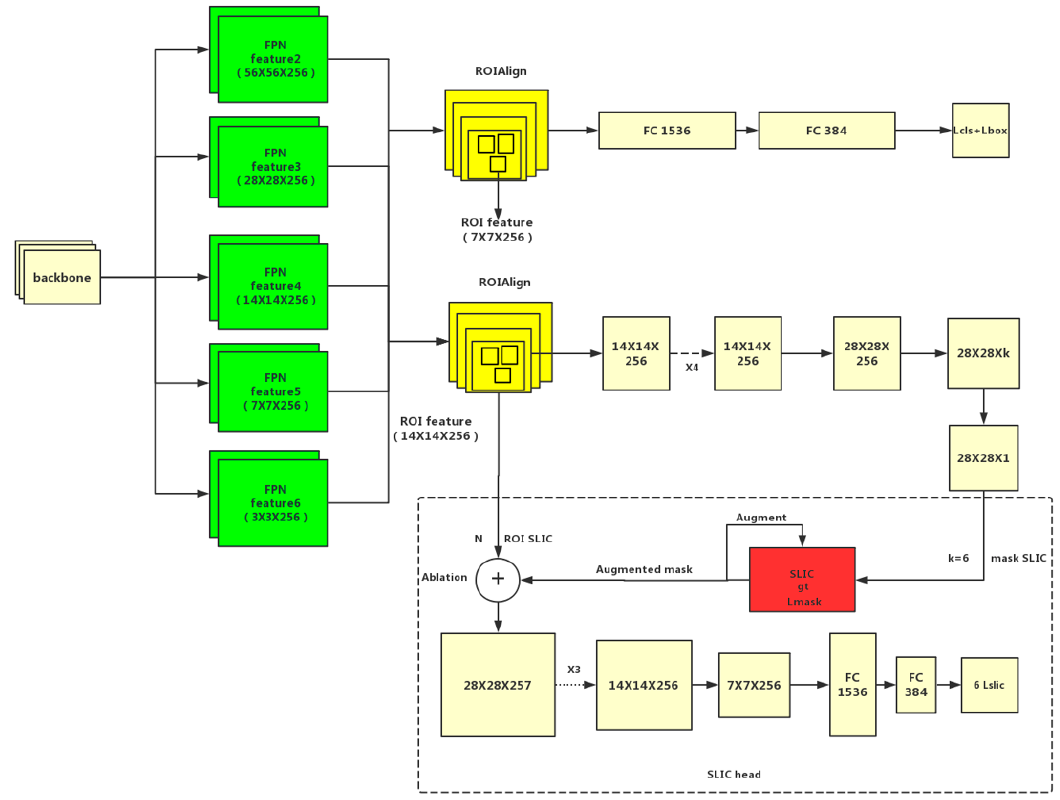
Figure 7. Structure diagram of the system is generated for the SLIC head.